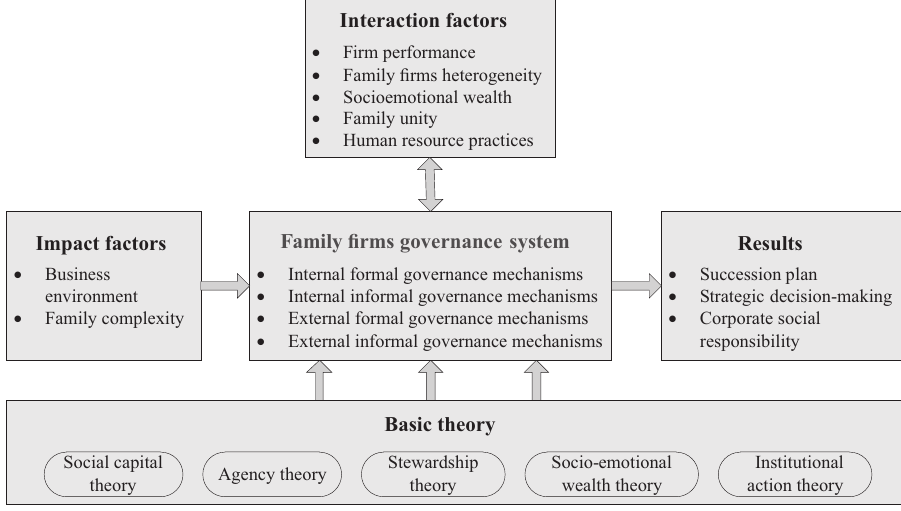
Figure 2. The overall conceptual structure of